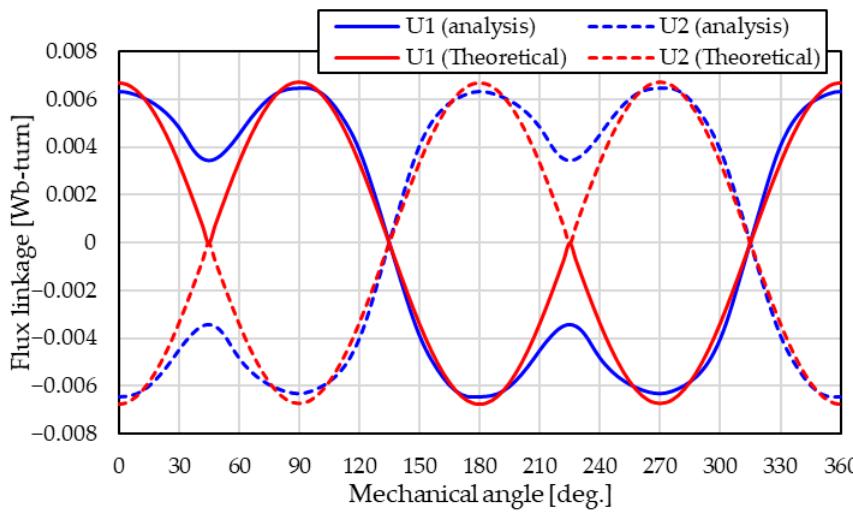
Figure 17. Analytical and theoretical flux linkage of the U1 and U2-phases at I d = − 36.74 A.